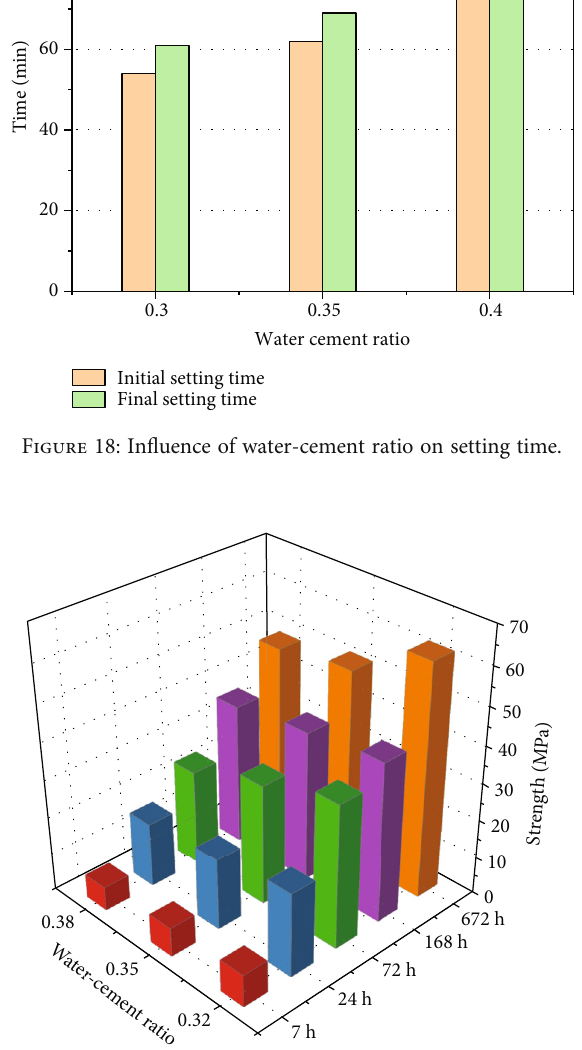
Figure 19: Strength of cement specimen at 28